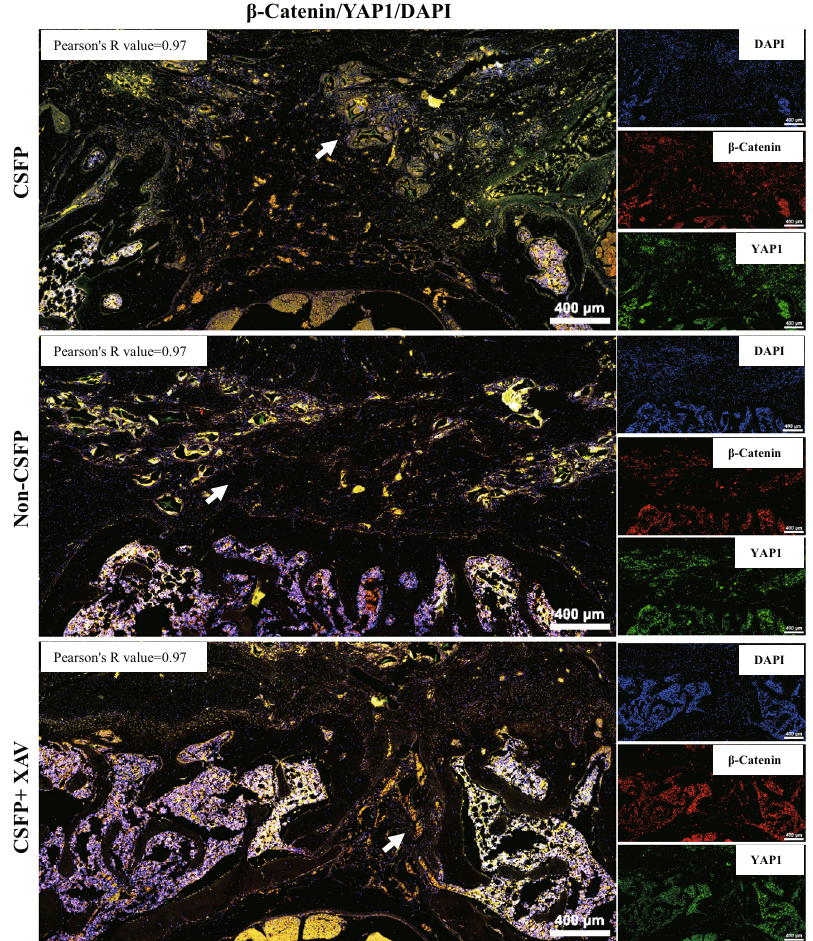
Fig. 7 Double immuno fl uorescent staining revealed colocalization of β -Catenin (red) and YAP1 (green). The white arrow shows the